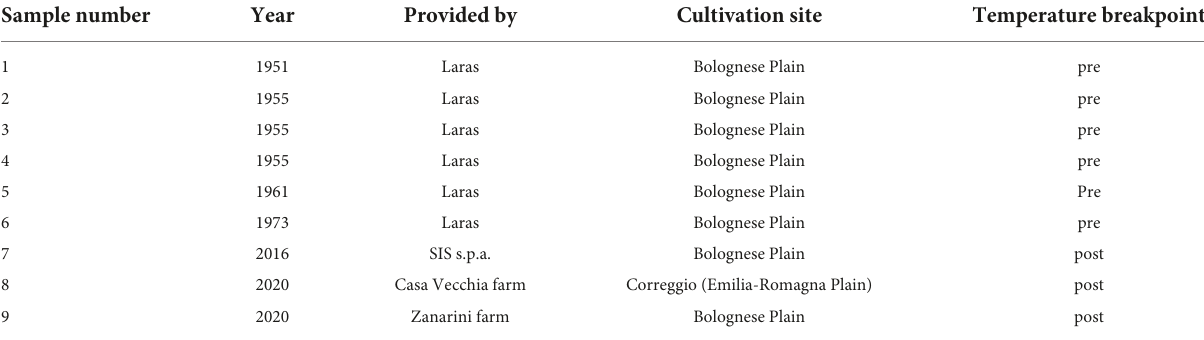
TABLE 1 San Pastore grain samples of pre- and post-temperature breakpoint period used in this study. Sample